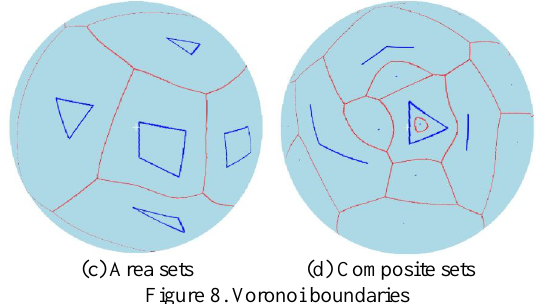
Figure 8. Voronoi boundaries